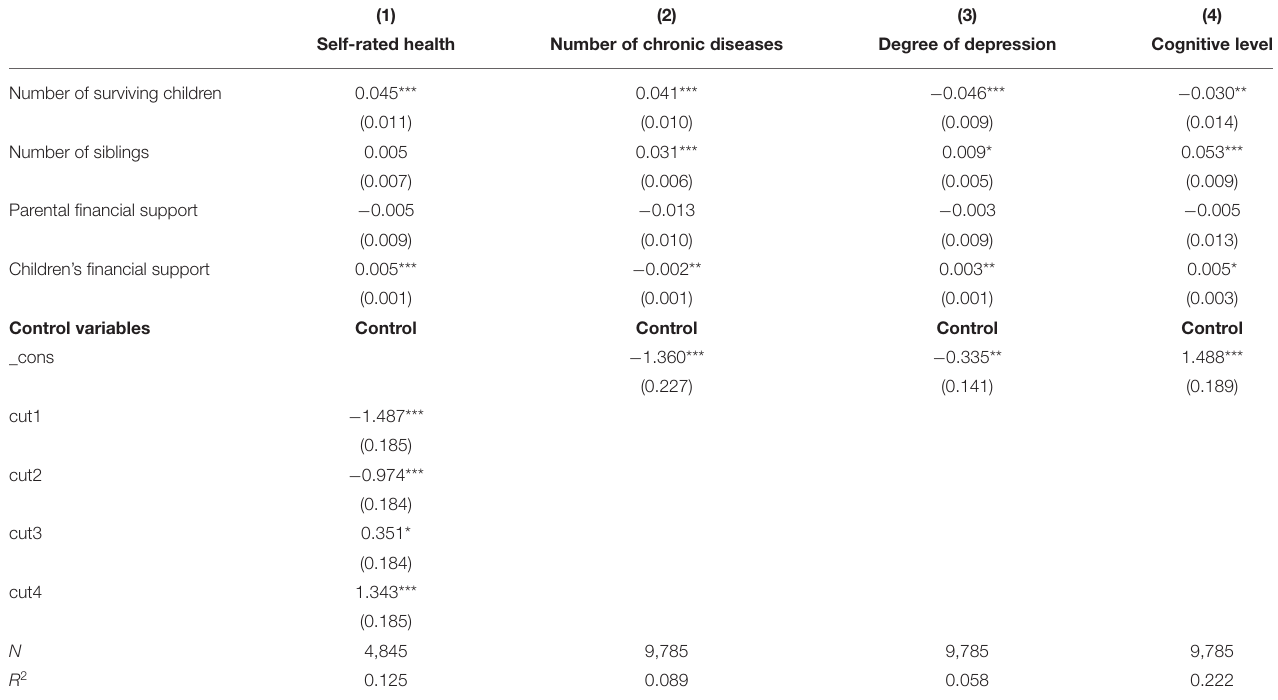
TABLE 2 | Impact of informal social support on the health of older